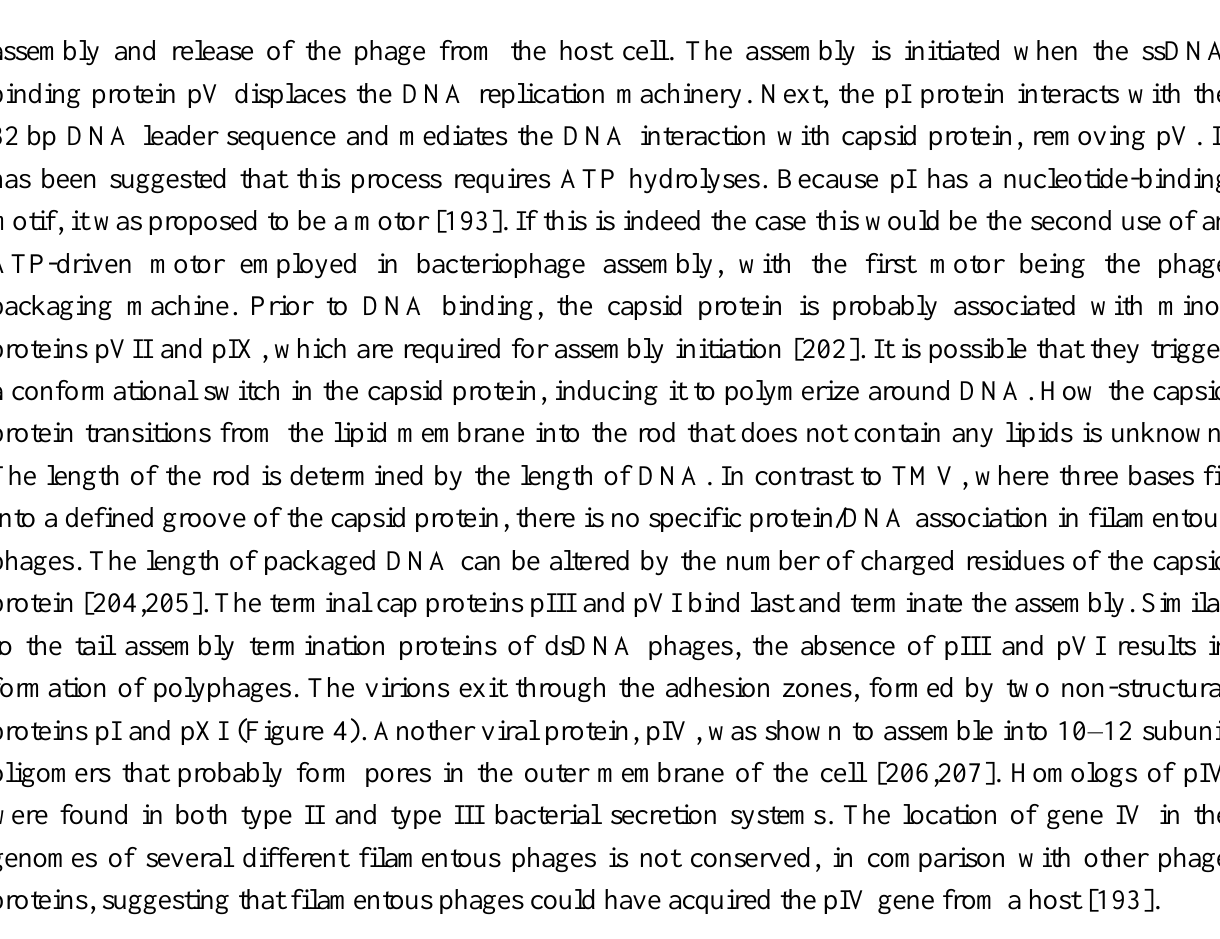
Figure 4. Model for the assembly and extrusion of filamentous phages. The figure was created based on a figure by Russel and Model